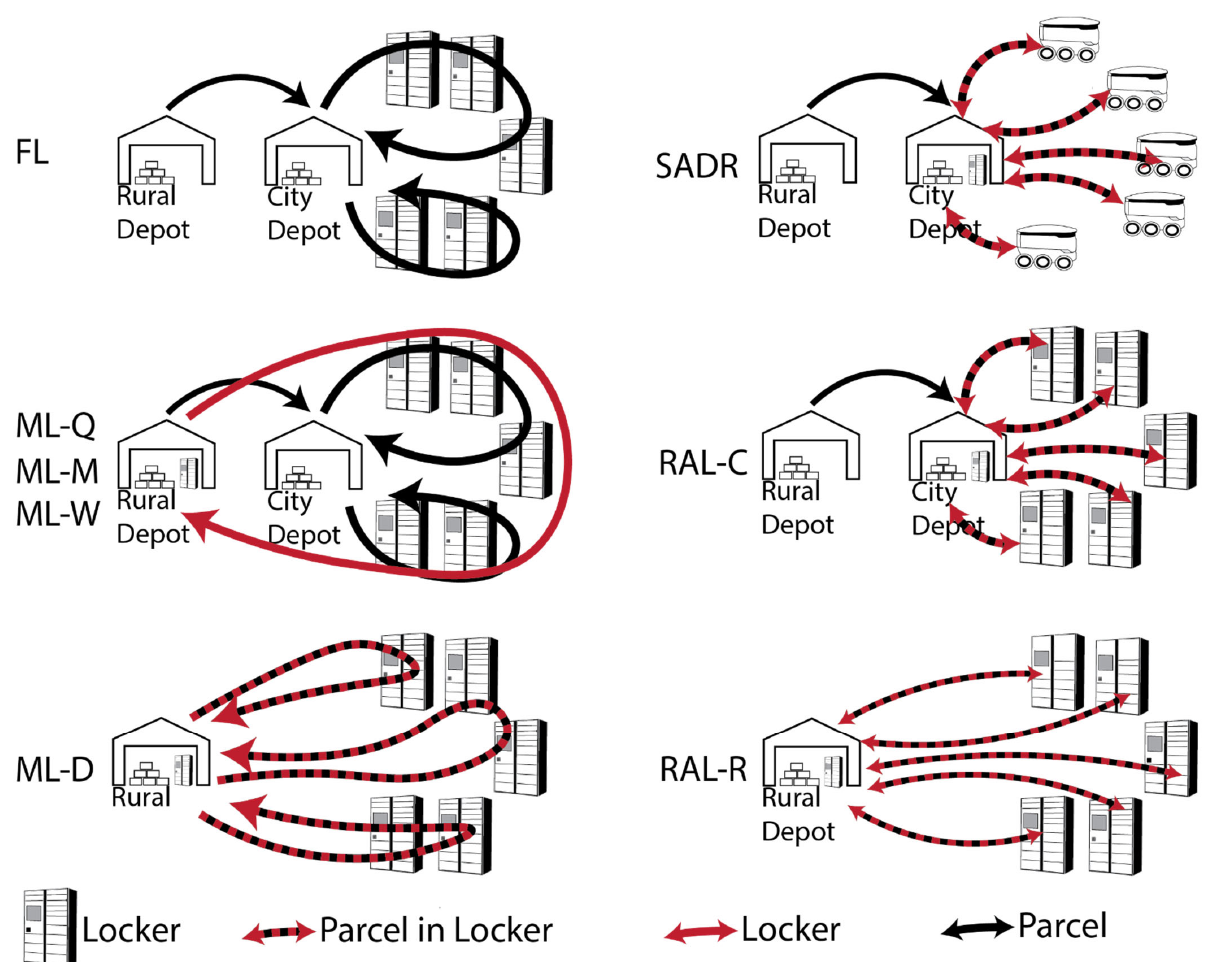
Figure 4. Delivery concepts: Fixed locker (FL), modular locker adjusted quarterly (ML ‐ Q), modular locker adjusted monthly (ML ‐ M), modular locker adjusted weekly (ML ‐ W), modular locker ad ‐